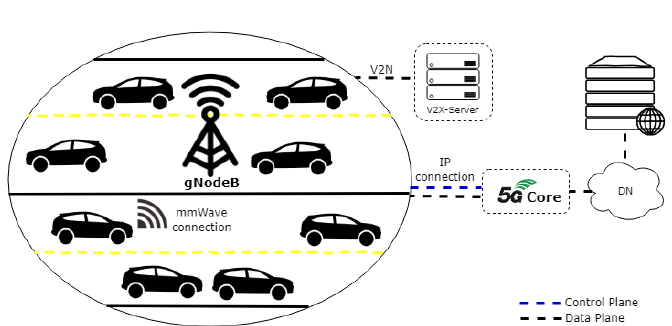
Figure 6. Network topology simulated of a fog